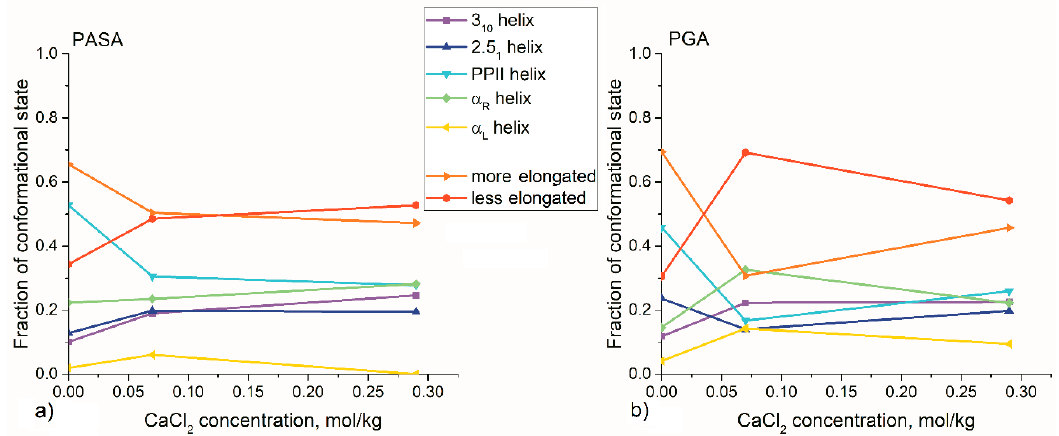
Figure 11. The results from the integration of the areas of the Ramachandran plots related to different secondary structures (more stretched (PPII and 2.5 1 helices) and less stretched ( α (left-handed and right-handed) and 3 10 helices). The Ramachandran plot with the specified areas is shown in Figure S2. ( a ) PASA ( b ) PGA.